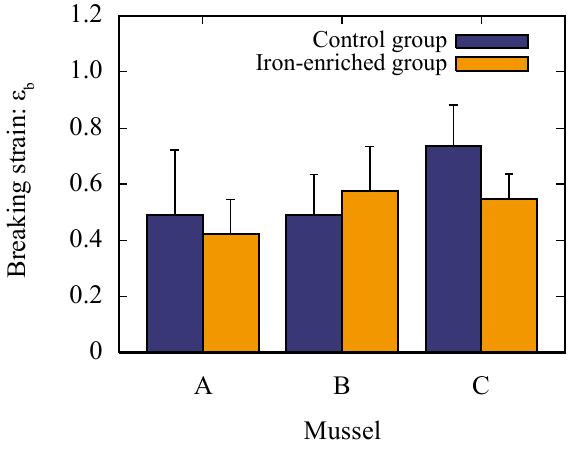
Fig. 15 Break strain of byssal threads (error bars show 95% mean confidence